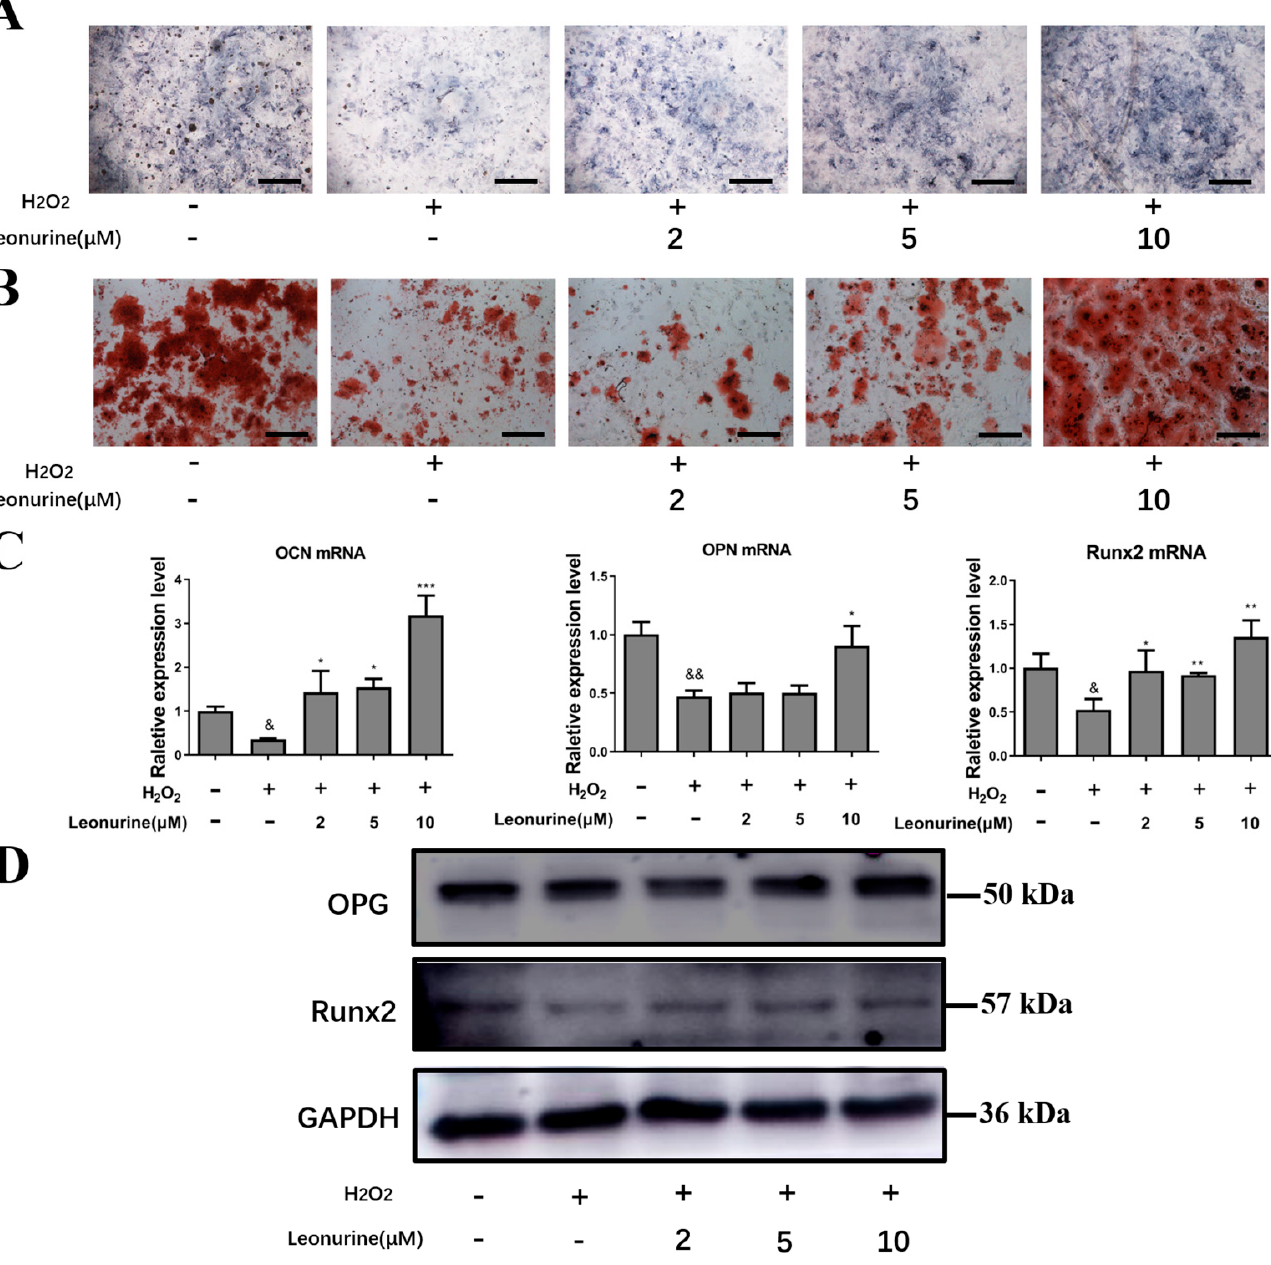
Figure 2. Effect of leonurine protection on BMSCs from ROS damage. ( A ) ALP staining of leonurine treated groups (0–10 µ M) at day 6 (scale bar = 200 µ M). ( B ) Aliza red staining of leonurine treated groups (0–10 µ M) at day 14 (scale bar = 200 µ M). ( C ) Osteogenic-related mRNA expression level. ( D ) Osteogenic-related protein expression level. (& p < 0.05, && p < 0.01 vs. control group. * p < 0.05, ** p < 0.01, *** p < 0.001 vs H 2 O 2 group).